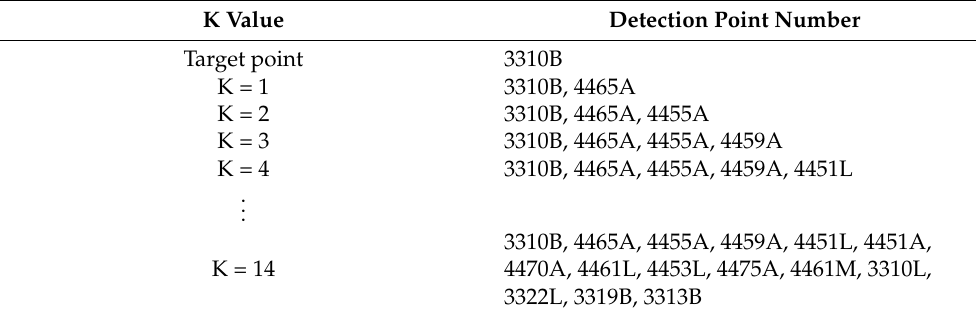
Table 2. Detection point numbers under different combinations.